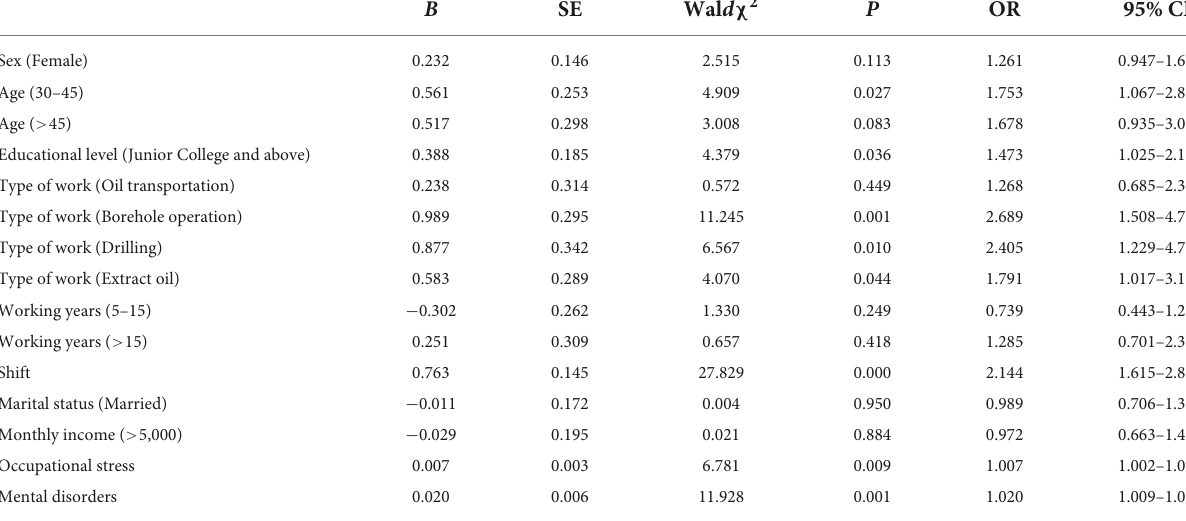
TABLE 4 Logistic regression analysis of factors influencing sleep disorders in oil workers. B SE Wal d χ 2